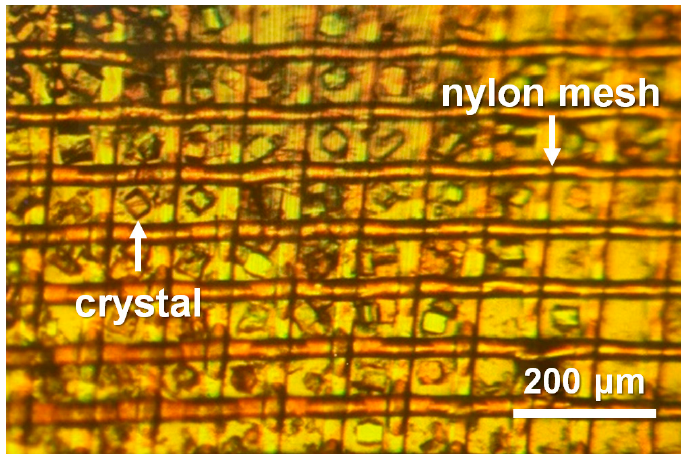
Figure 7. Photograph of NAM-based sample holder after FT-SSX data collection. No physical damage to nylon-mesh or polyimide film was seen due to synchrotron X-ray.